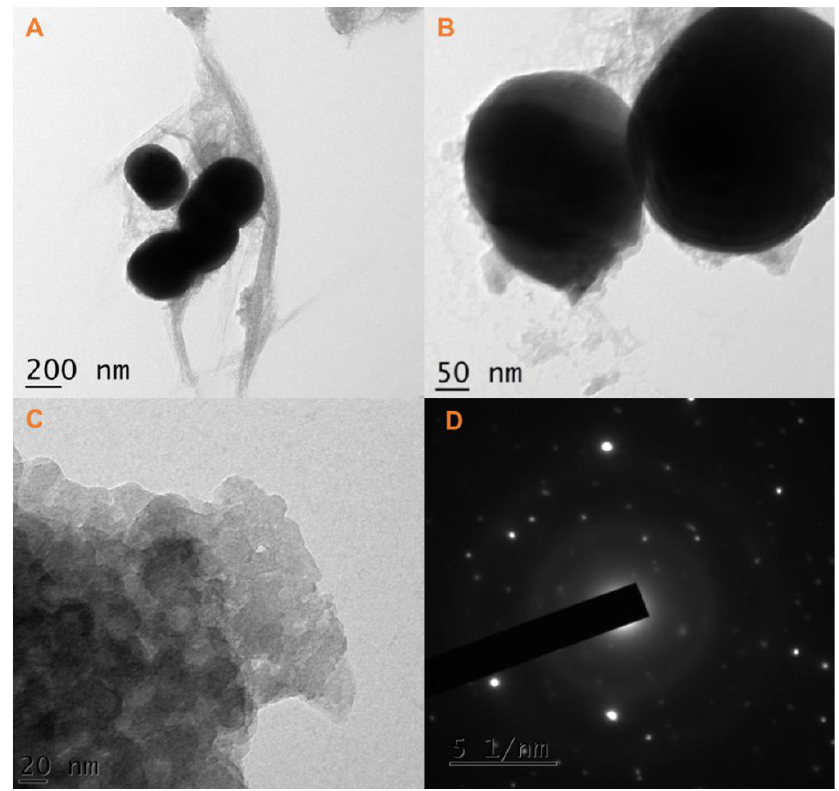
Figure 5. HRTEM images of GdFeO 3 nanoparticles annealed at a temperature of 800 °C ( A – C ) and the corresponding SAED pattern for Figure 5c ( D ).